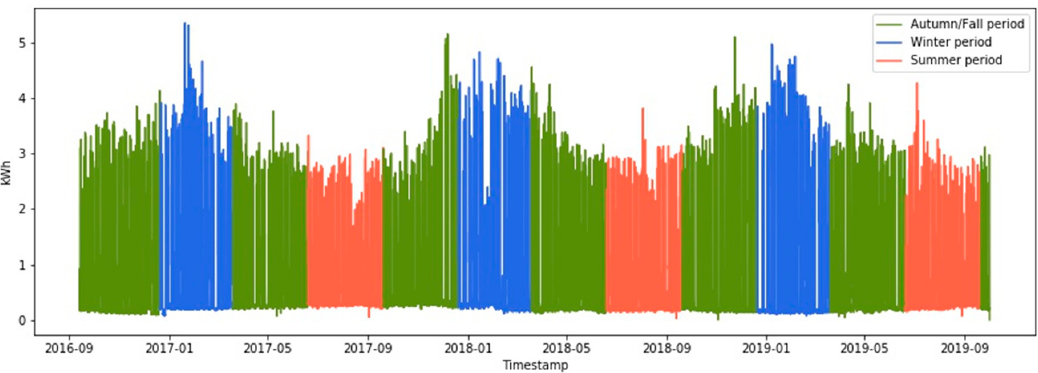
Figure 4. Hourly kWh consumption from September 2016 to September 2019 with the summer and winter periods highlighted.